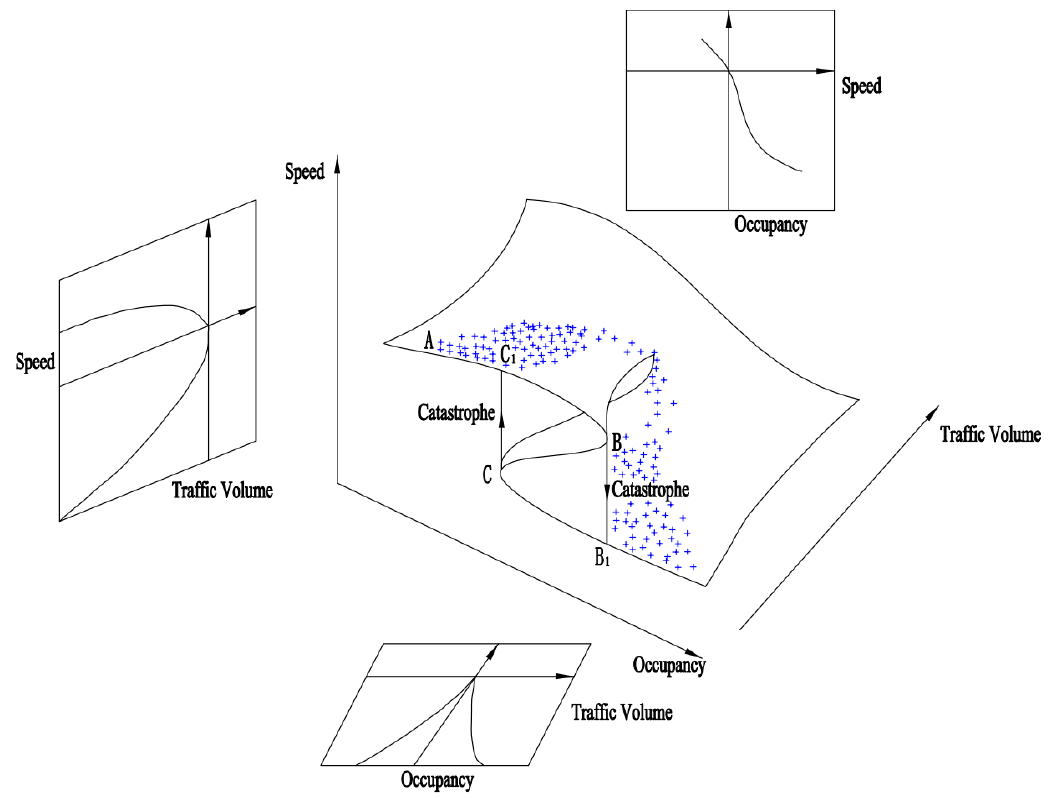
Figure 7. Equilibrium surface of cusp catastrophe theory.